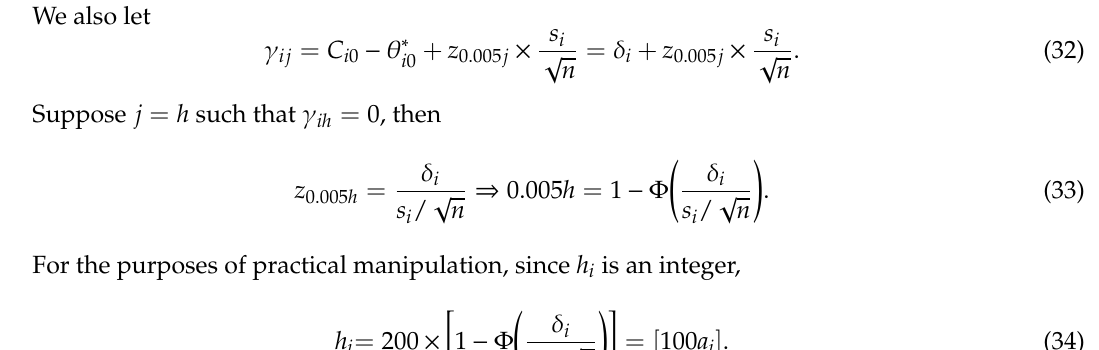
Figure 1. Membership functions of ( )